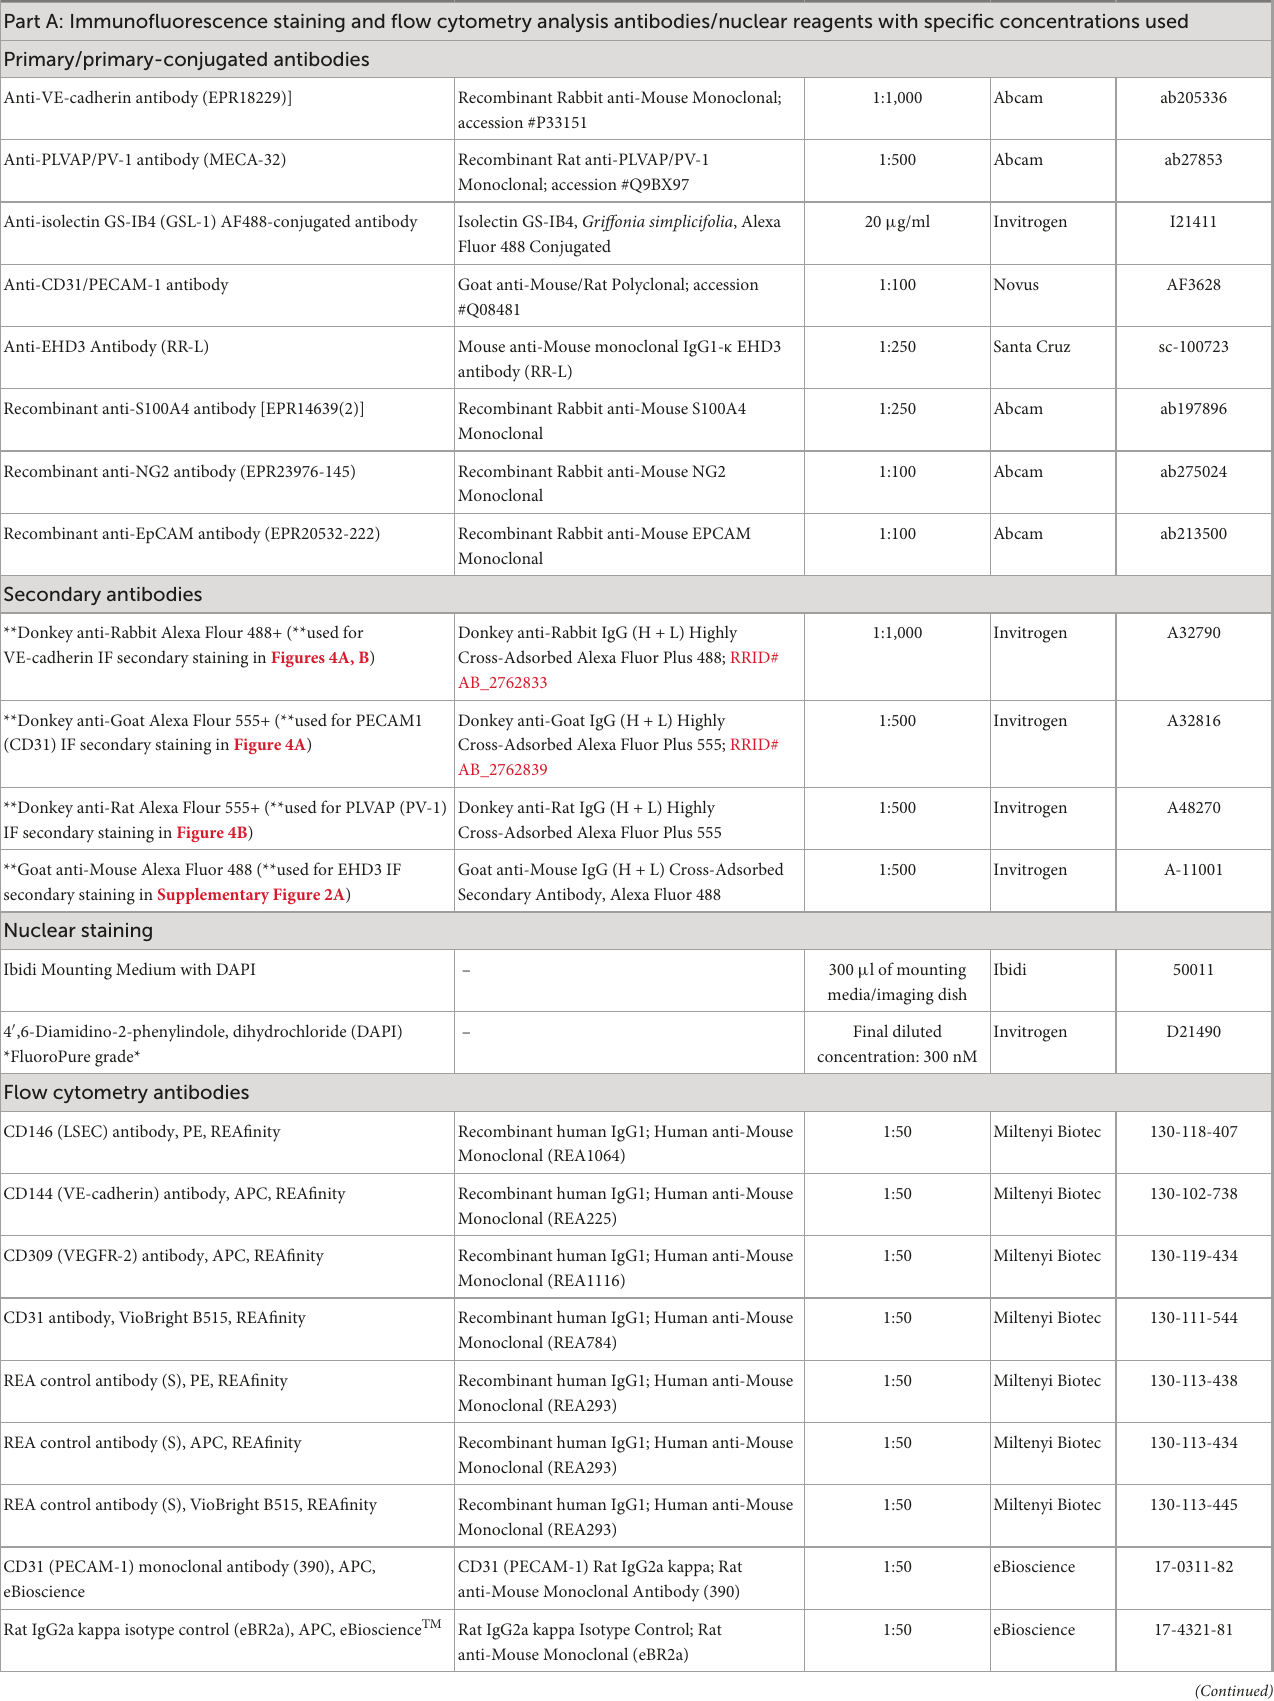
TABLE 2 Reagents and resources list for MRPEC isolation. Antibodies/reagents Host/clonality Concentrations